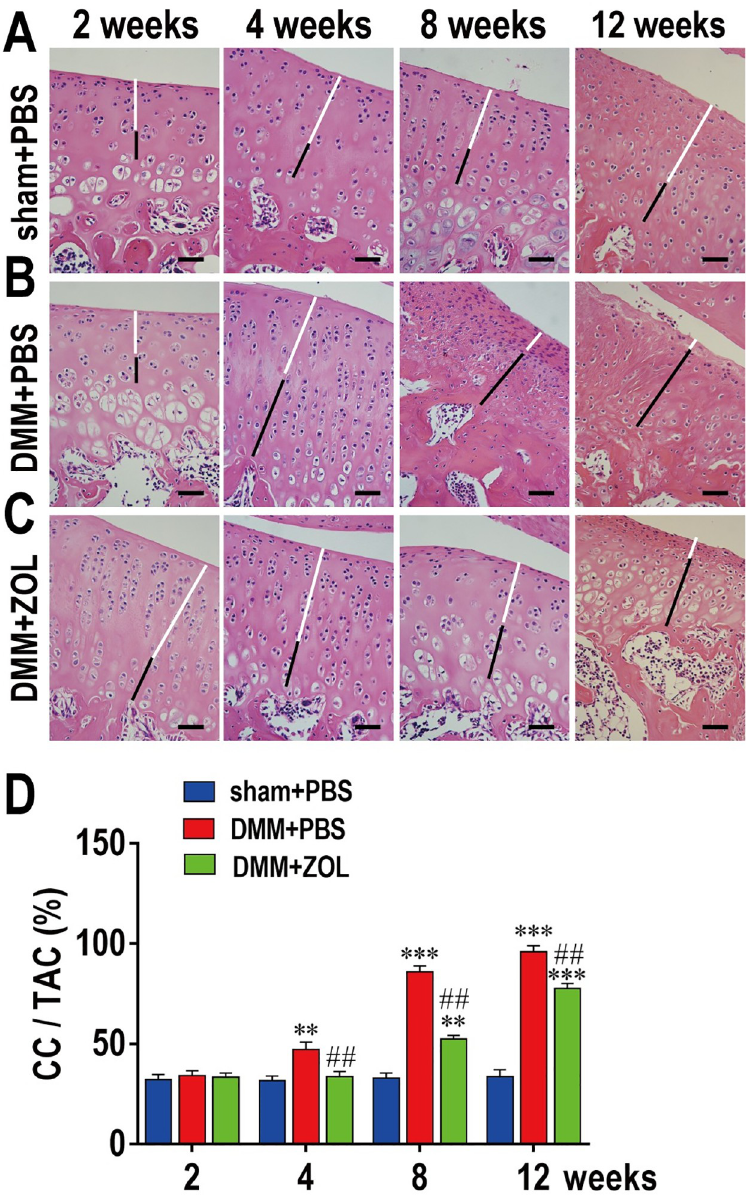
Fig 3. ZOL inhibits the increase of calcified cartilage in DMM-induced OA rats. Histological analysis of articular cartilage stained with (A, B and C) HE, in coronal sections of tibia at various time-points. Scale bar, 100 μ m. Quantitative analysis of (D) CC/TAC at various time-points (n = 6 per group/time point). �� P < 0.01 and ��� P < 0.001, compared with sham+PBS group; ## P < 0.01 and ### P < 0.001, compared with DMM+PBS group.